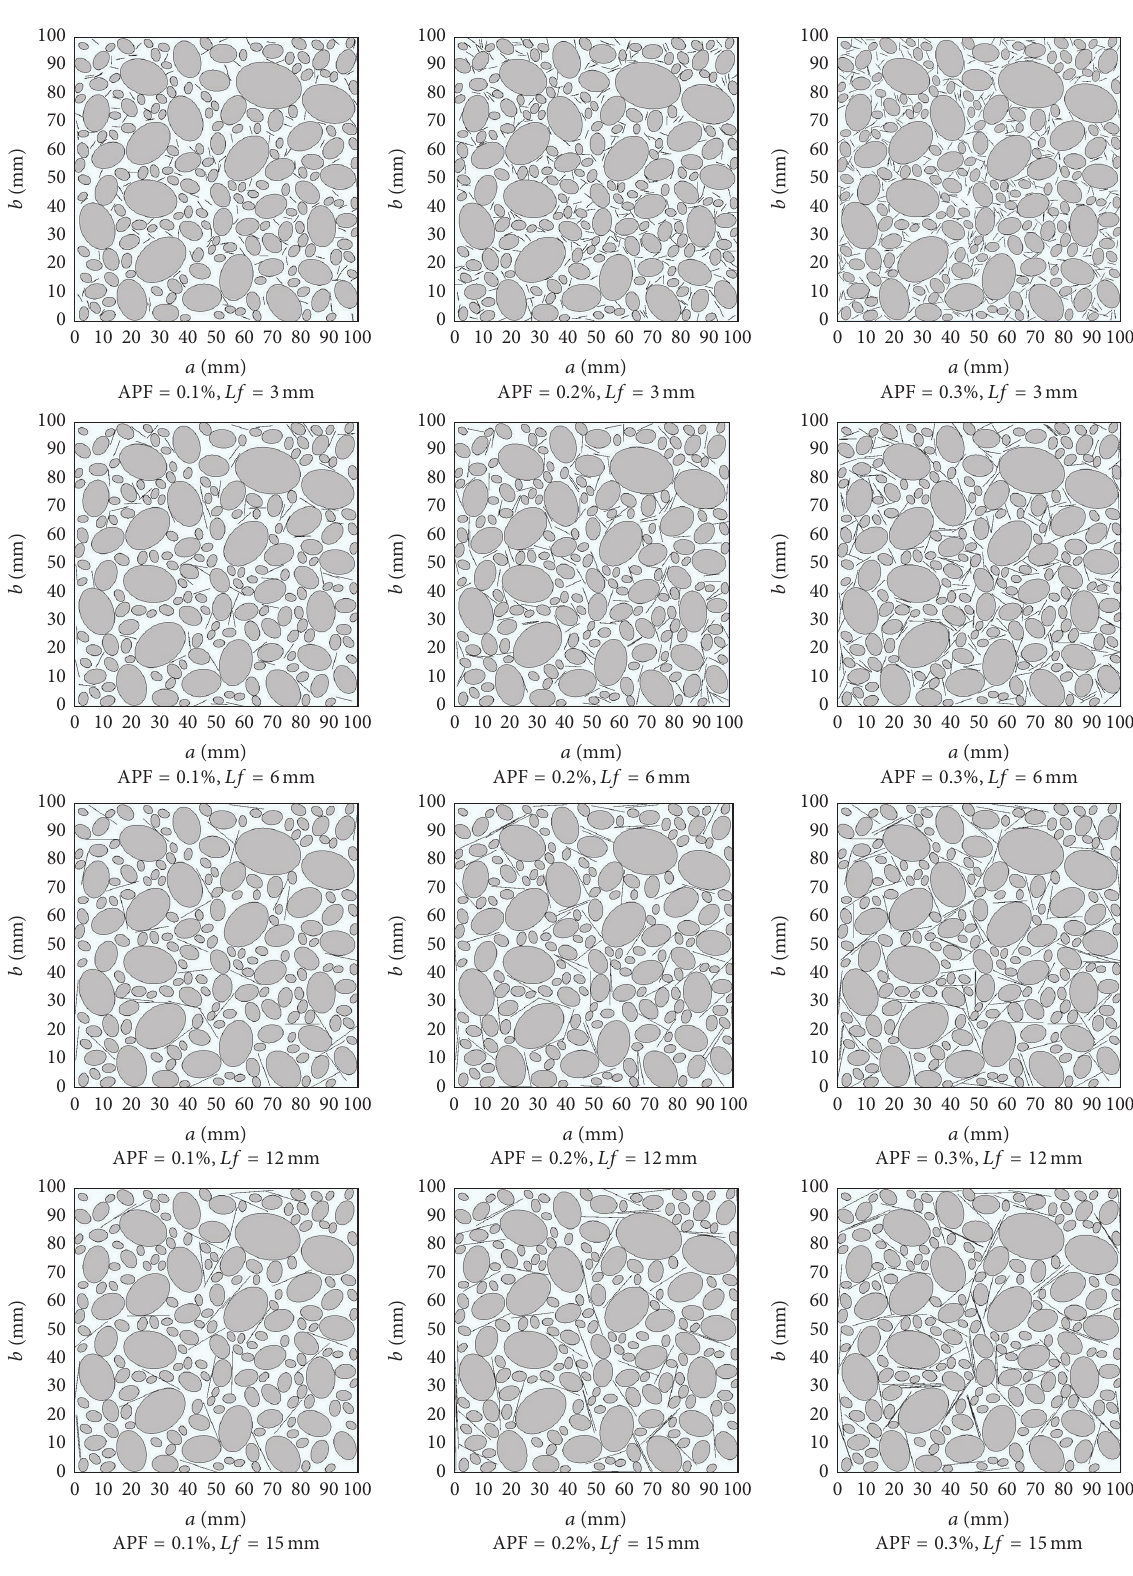
Figure 3: Micromechanical models of